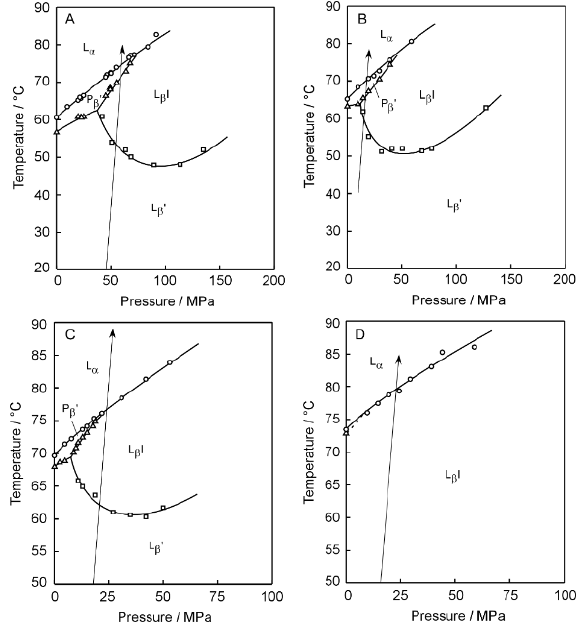
Figure 5. Temperature ( T )–pressure ( P ) phase diagrams of the C n PC bilayer membranes ( n = 19–22): ( A ) C19PC, ( B ) C20PC, ( C ) C21PC, ( D ) C22PC. The arrow shown in each diagram indicates the